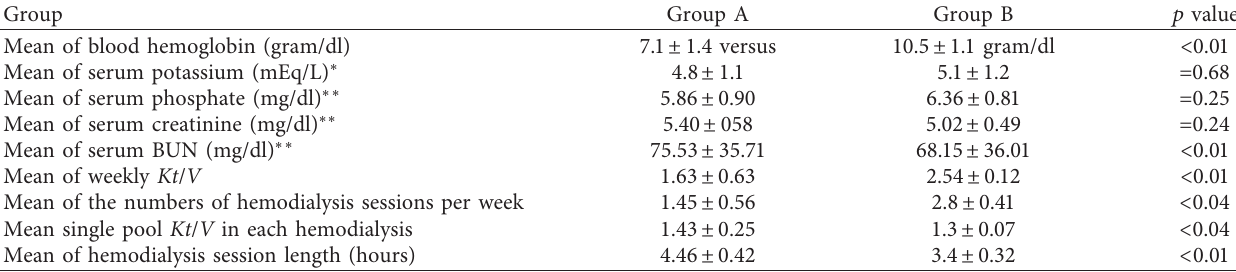
Table 2: Some hemodialysis characteristics and laboratory parameters in two groups.